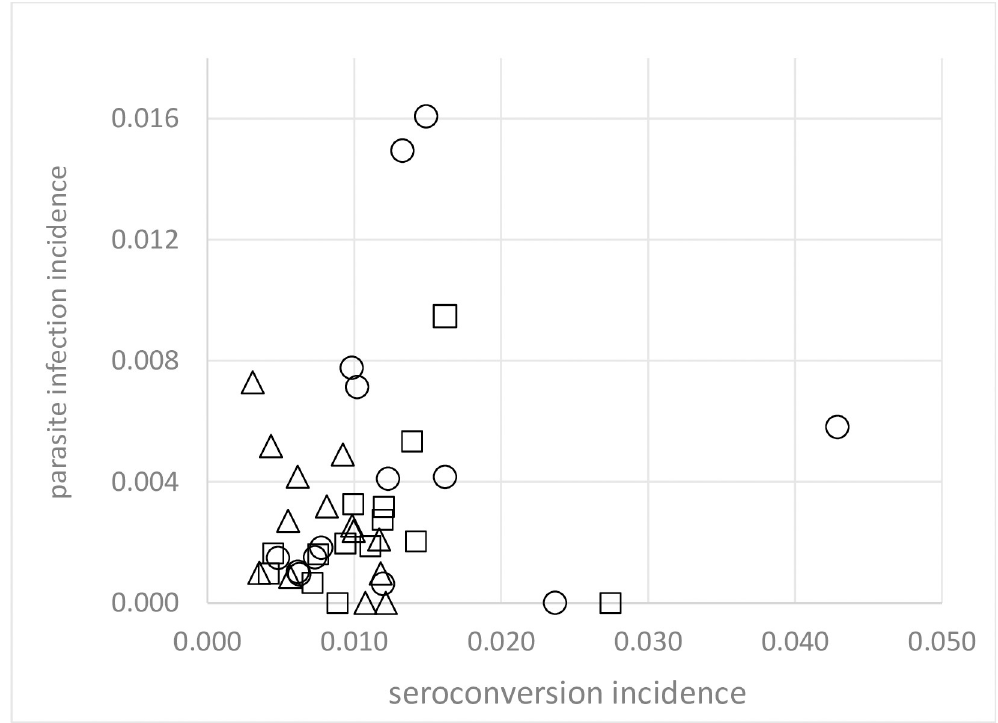
Fig 4. Association between annual incidence estimates of confirmed parasite infection and seroconversion at follow-up in control ( � ) collar ( 4 ) and pheromone ( □ ) intervention